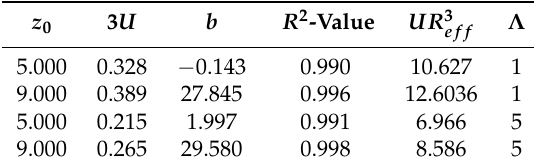
Figure 4. ( Left ) Migration of two RBCs starting at 5 µ m and 9 µ m away from the channel wall, respectively. ( Right ) Non-dimensional trajectories and their linear fit to approximate Olla’s prediction (Equation (4)). Table 1. Fitting parameters for the non-dimensional data represented in the right image of Figure